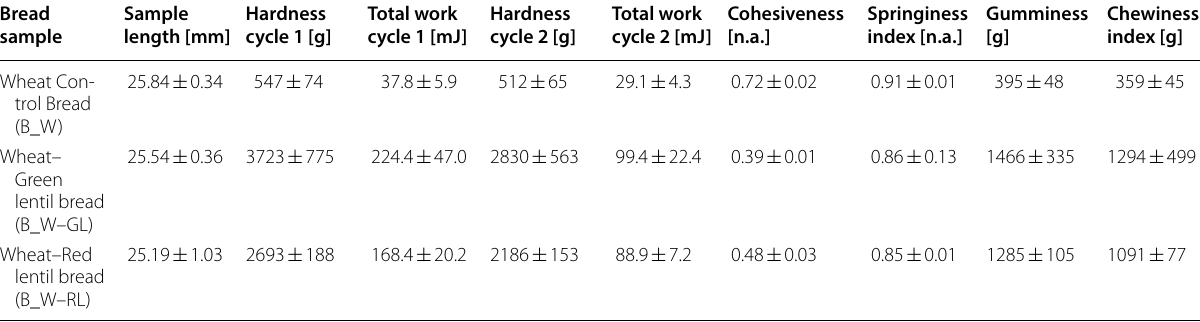
Table 4 Texture profile analyses for bread samples obtained from wheat–lentil composite flours as compared to wheat control bread (means standard deviations) ± Bread